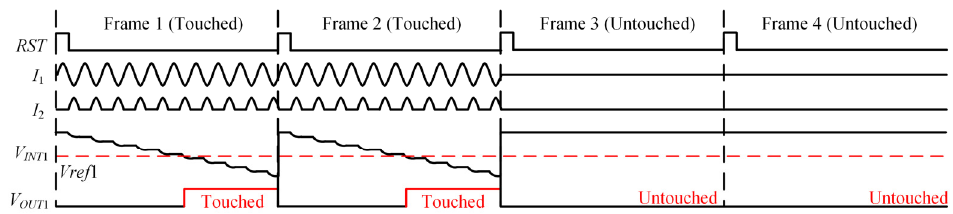
Figure 6. The working sequence of the proposed RX judgment circuit. The voltage to current convertor output current I 1